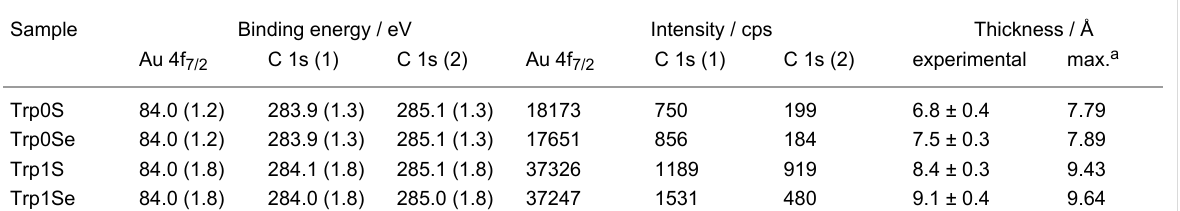
Table 2: Results of the evaluation of XP spectra recorded from Trp0S-, Trp0Se-, Trp1S- and Trp1Se-SAMs on Au(111). The full width at half maximum values for XPS data fitting are given in braces. Additionally to the experimental layer thicknesses that result from the XP data, a theoretical- ly possible maximum monolayer thickness is given. See text for explanation.